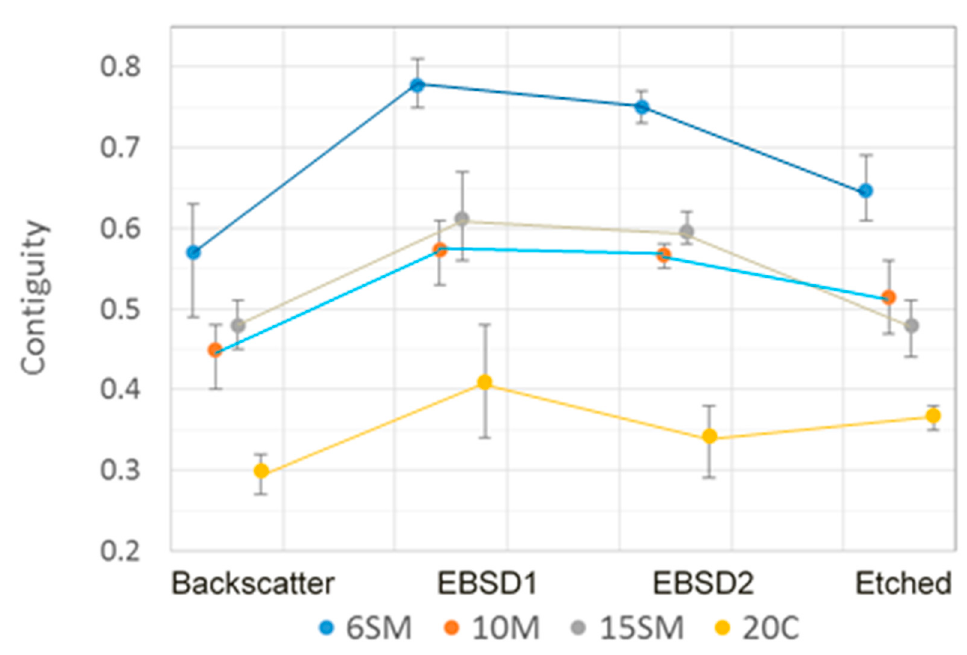
Figure 6. Summary of contiguity measurements. Error bars show a range of measurements after excluding outliers.